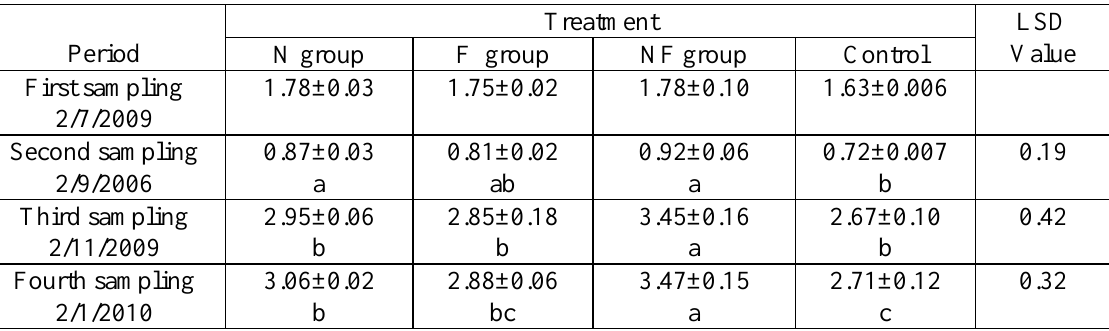
Table (1) Effect of Nigella sativa and / or Fenugreek seeds in the diet greasy wool weight (gm) of Awassi male lambs (means ± SE).